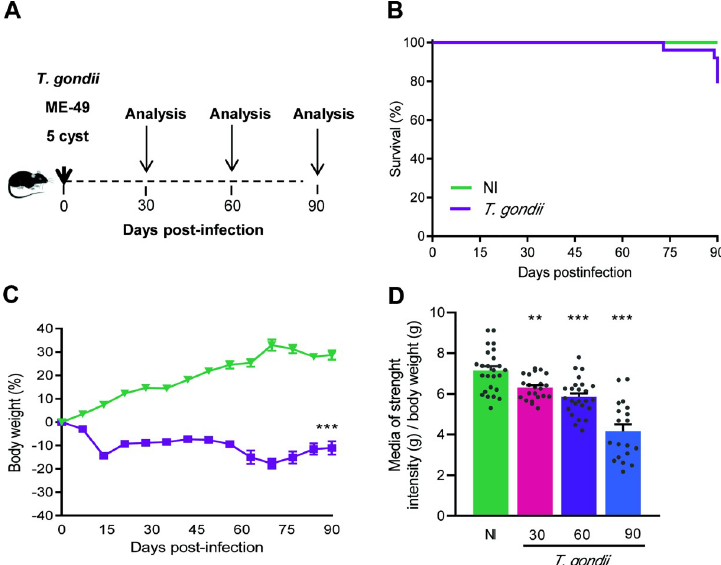
Fig 2. C57BL/6 mice chronically infected with the ME-49 Toxoplasma gondii strain survive and show weight and muscle strength loss. ( A ) Mice were infected with 5 cysts of the ME-49 T . gondii strain, the clinical follow-up and the mortality were assessed and recorded weekly, and the kinetics of infection was evaluated at 30, 60 and 90 dpi. ( B ) The survival curve shows a survival of 100% at 30 and 60 dpi, and 83% (19/24) at 90 dpi, compared to 100% in the age- and sex-matched NI control group. ( C ) Infected mice showed body weight loss during the acute phase of the infection (up to 15 dpi), after this period, the weight loss ceased. ( D ) Muscle strength was compromised in infected mice; values of muscle strength are shown as gram force (gf) / body weight (g). Each experimental group consisted of 4–6 NI mice and 10–19 T . gondii-i nfected mice. Each circle represents an individual mouse. Data are expressed as means ± SEM, and were analyzed using Welch’s test ( C ), and ordinary one-way ANOVA ( D ). �� , p < 0.01. ��� , p < 0.001, comparing T . gondii- infected and NI